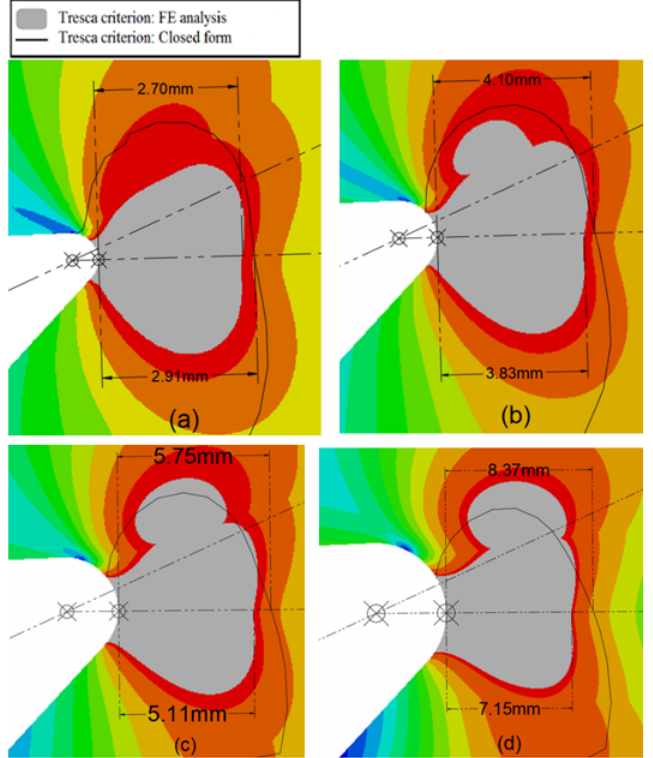
Figure 8. Plastic zones obtained from FE analyses and the proposed methodology based on the Tresca yield criterion, with notch tip radii of ( a ) 0.5 mm, ( b ) 1 mm, ( c ) 2 mm, and ( d ) 4 mm. Notch rotation angle = 25°. Applied loads are 35, 40, 44, and 48 kN, respectively.